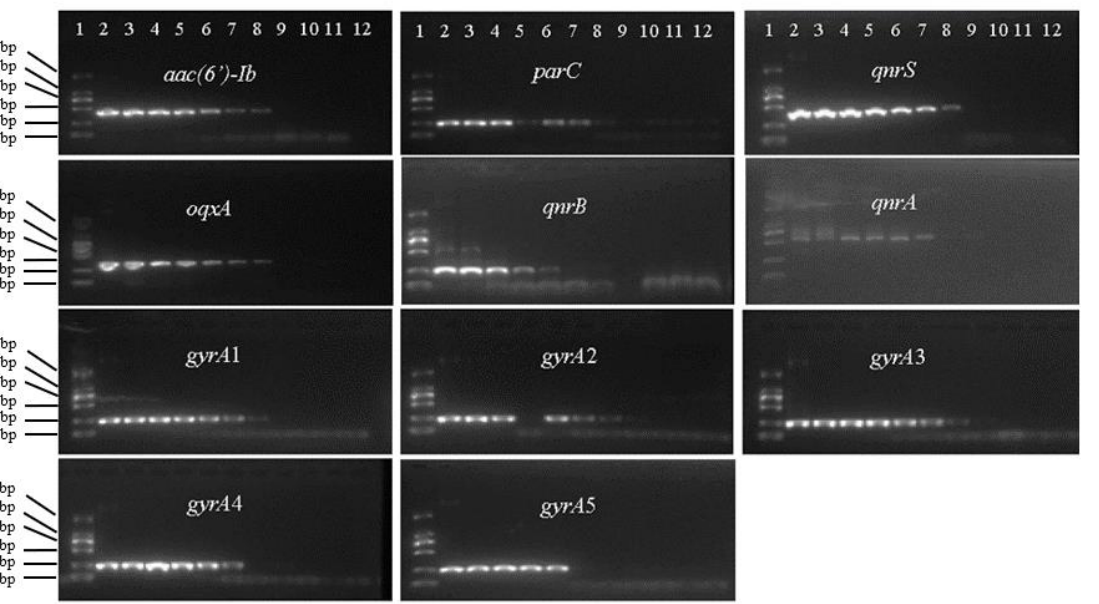
Figure 3. Limit of detection of PCR for the target DNA. In all gels: lane 1, DL 2000 DNA marker; lanes 2–11, amplicons obtained using template DNA (10 1 –10 10 -fold diluted); lane 12, double-distilled H 2 O, which served as the blank control.